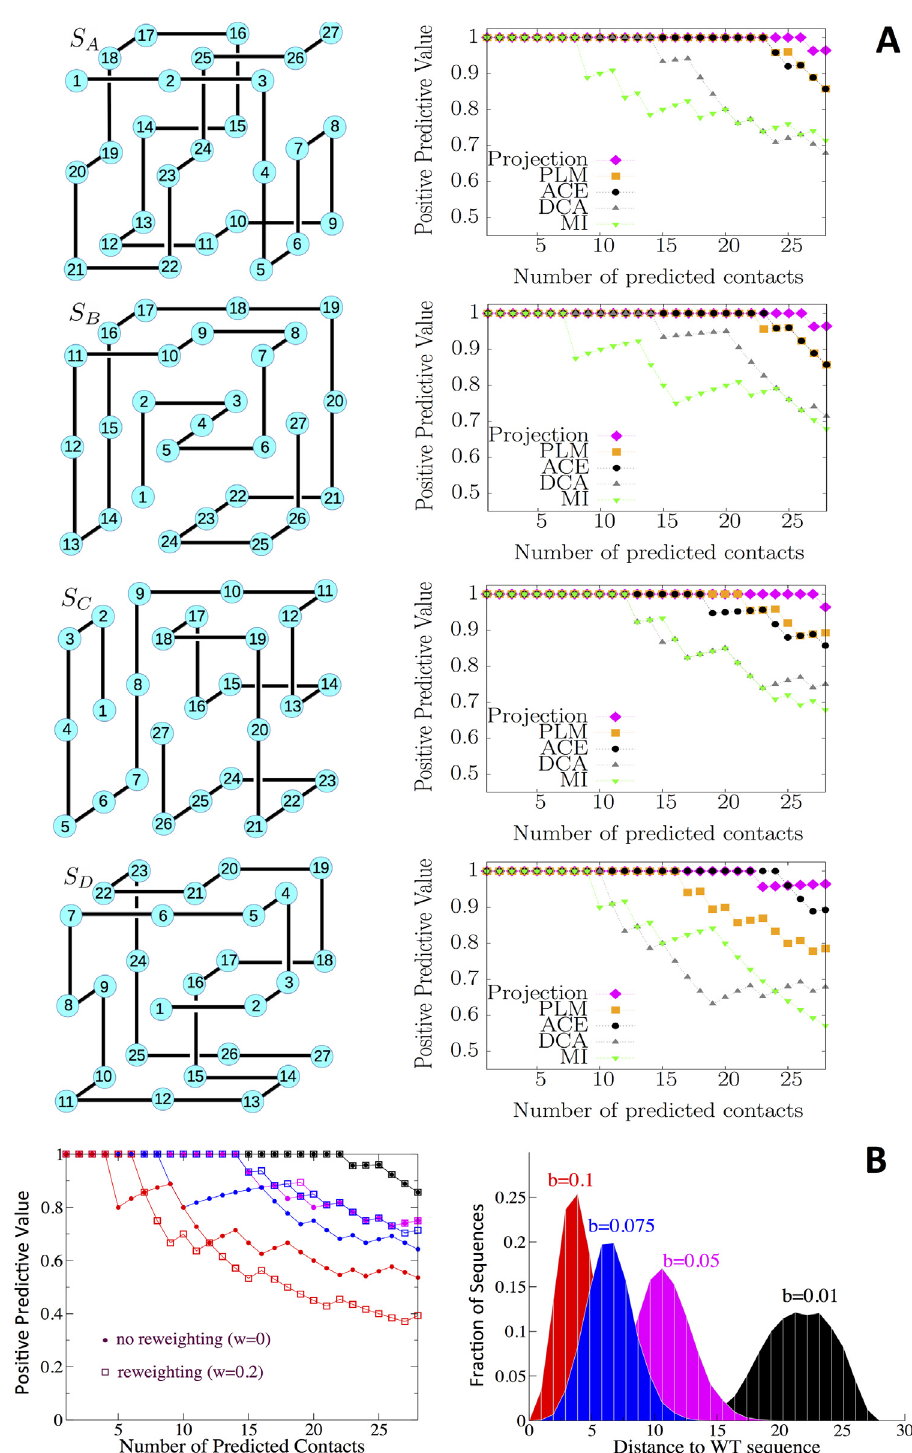
Fig 2. Inverse statistical approaches are able to extract structural information from sequence data of lattice proteins. A. Left: Structures S A , S B , S C , S D . Amino acids (blue circles) are shown with their number, running from 1 to 27 along the protein backbone (black line). There are 28 contacts between nearest- neighbor amino acids not supported by the backbone. Right: Positive predictive values (PPV), defined as the fraction of contacts among the k top scores, with the MI, DCA, PLM, ACE, and Projection